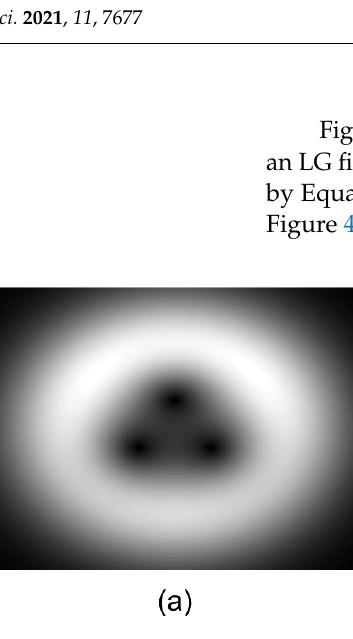
Figure 4. ( a ) Intensity of the vortex beam with a topological charge of m = 3 after separation into three vortices with topological charges of m = 1, ( b ) phase plotted as arg ( f LG ( r , θ )) , ( c ) pseudo-phase, plotted as arg ( I con ( r , θ )) for the vortex beam with a topological charge of m = 3. The figure shows the convolution operation. Colored and superimposed pseudo-phase and original phase maps are presented in Figure 5. Vortex positions are indicated by the red circles, which are at the point where the spiral connected with the 2π phase jump ends.